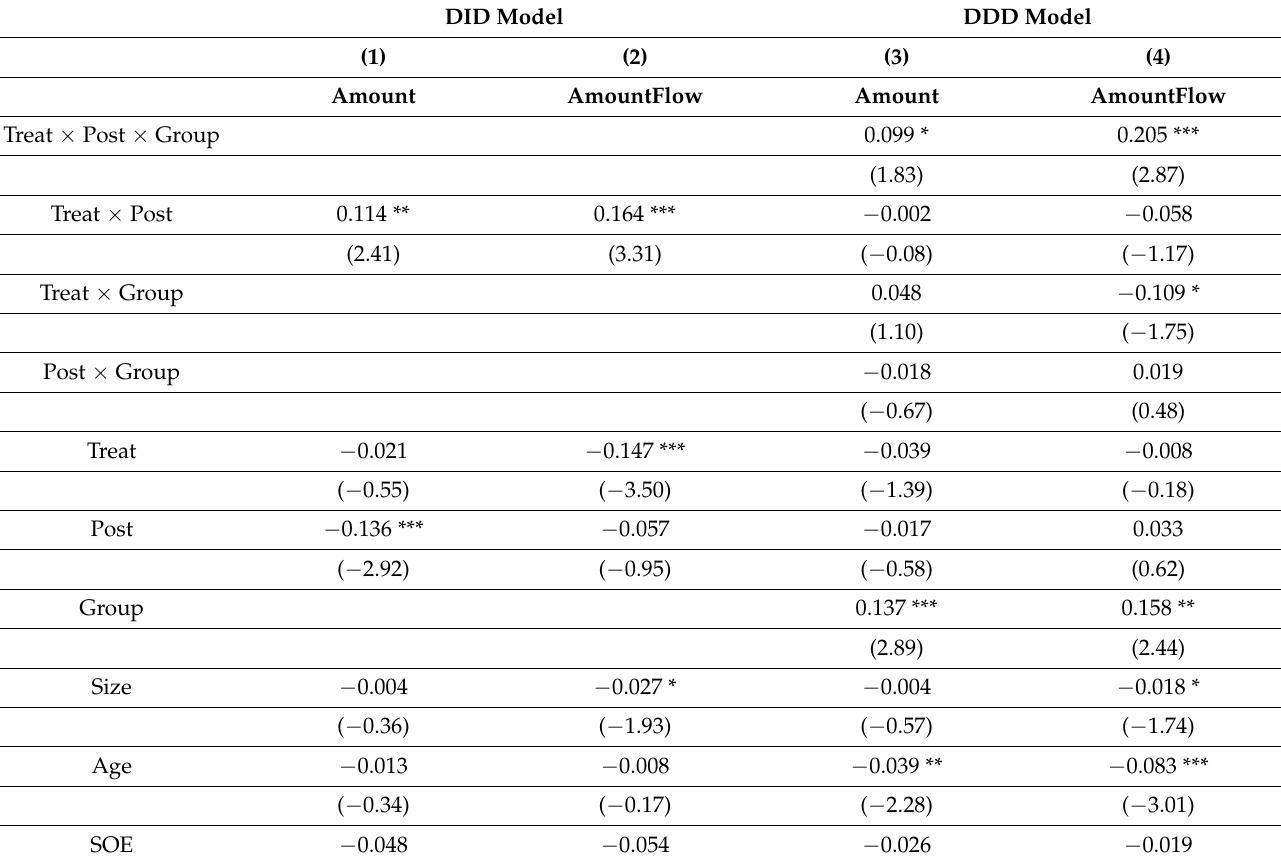
Table 3. Preliminary regression results for the difference in difference (DID) and difference in difference in difference (DDD) models. DID